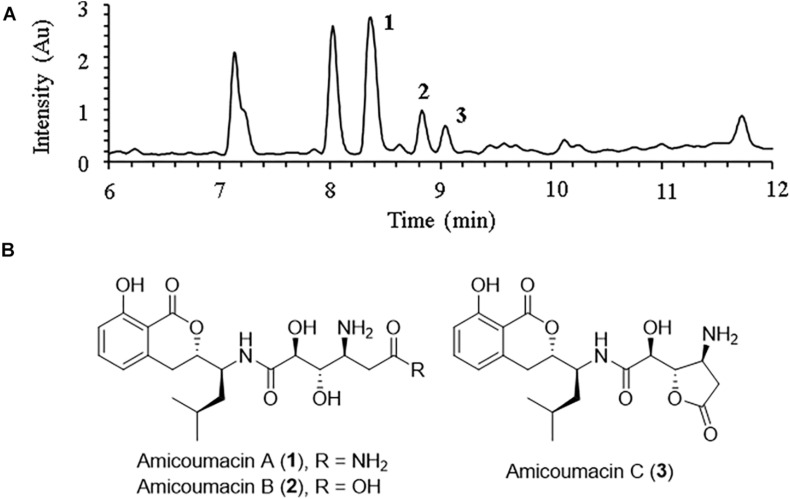
LC-MS profile of ethyl acetate (EA) extract from B. subtilis BSXE-1601 cell-free supernatant. (A) Amicoumacins A-C (1–3) were revealed from the chromatogram (DAD, λ = 314 nm) based on their specific m/z: 424 [M + H]+ for 1, 425 [M + H]+ for 2 and 407 [M + H]+ for 3; (B) Structures of amicoumacins.